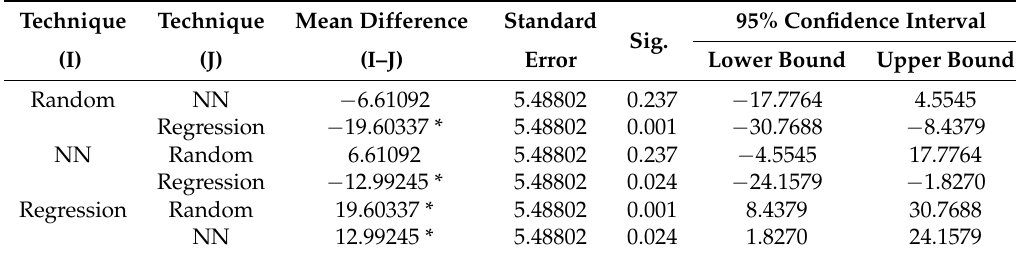
Table 12. LSD: Multiple Comparisons (Random, NN and our Regression) significant w.r.t average convergence. * The mean difference is significant at the 0.05